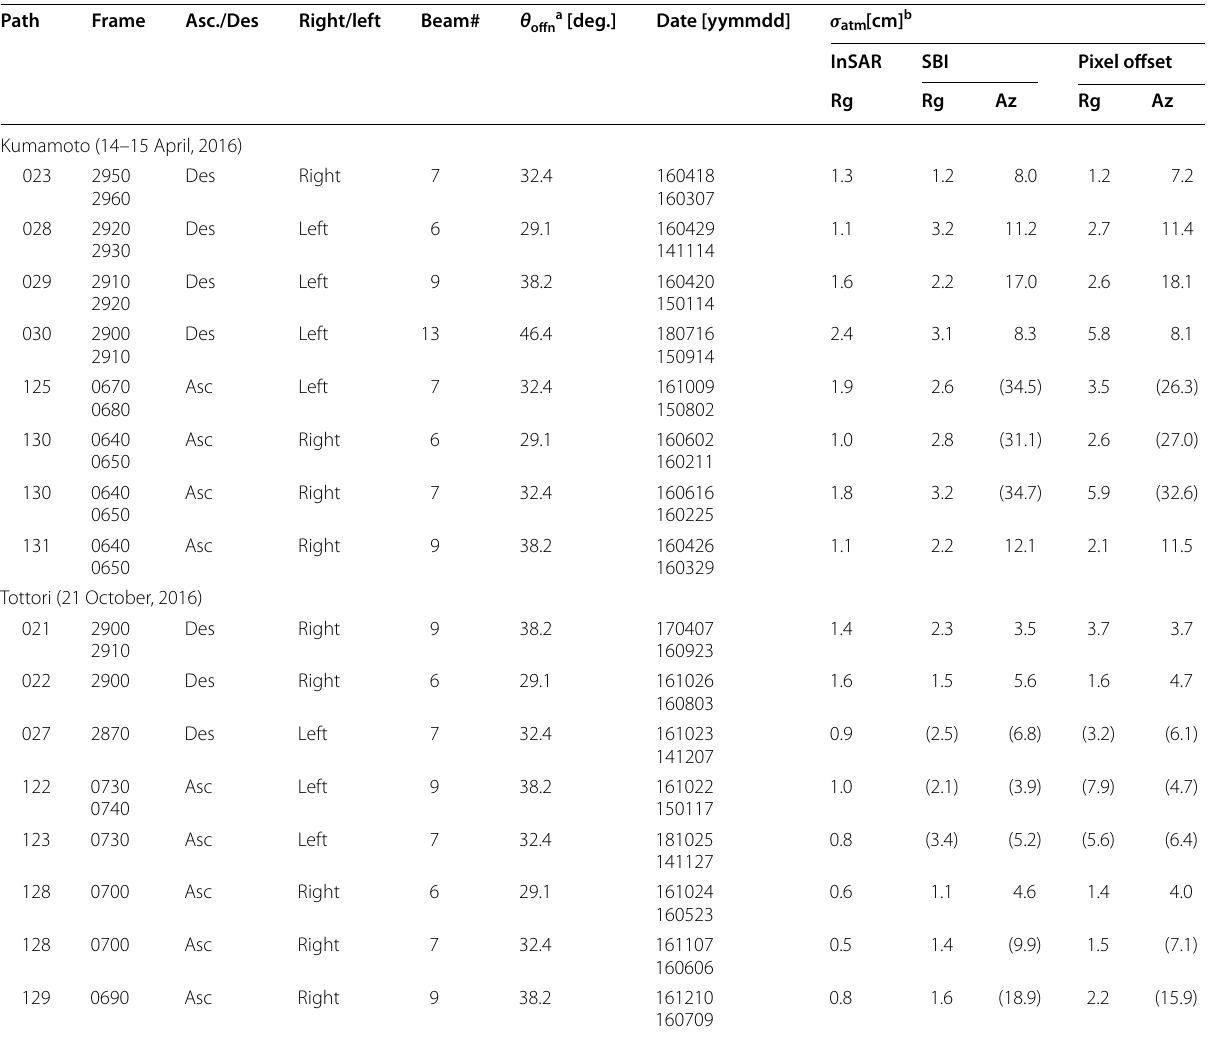
a Off-nadir angle at the scene center b Data in parentheses were not used for the final analysis due to large noise errors or